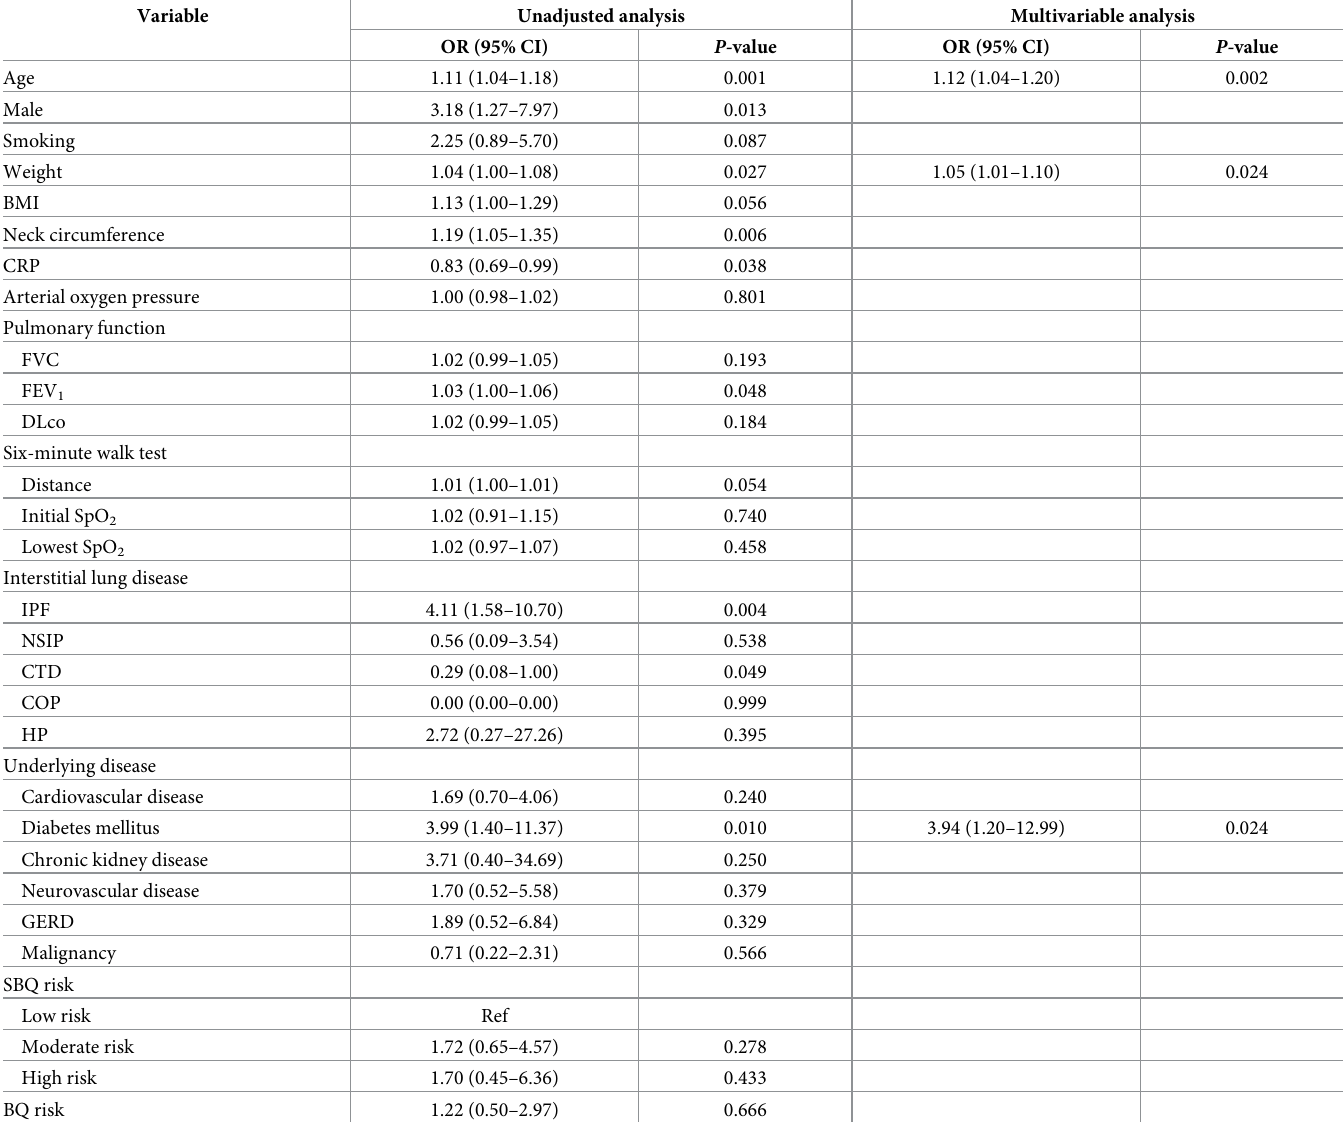
Table 3. Predictive factors for OSA in patients with ILD assessed using a logistic regression